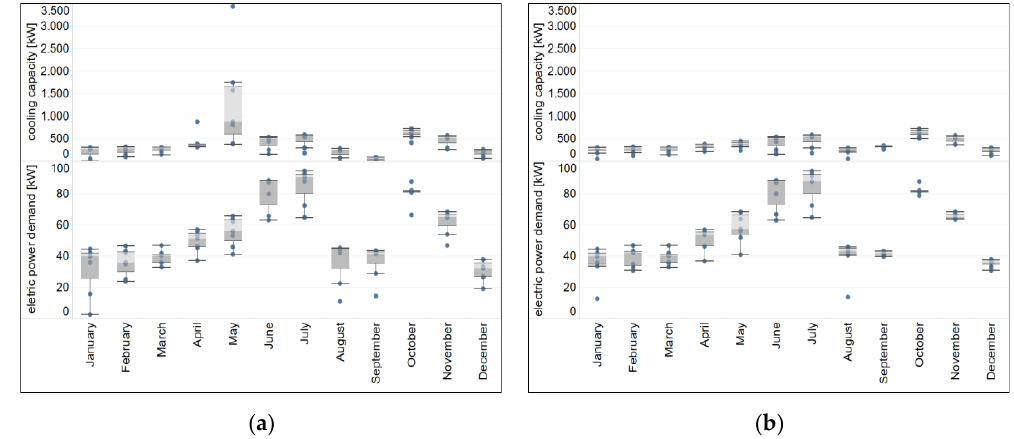
Figure 9. Box plots of cooling capacity and electric power demand: ( a ) before outlier filtering; ( b ) after outlier filtering.